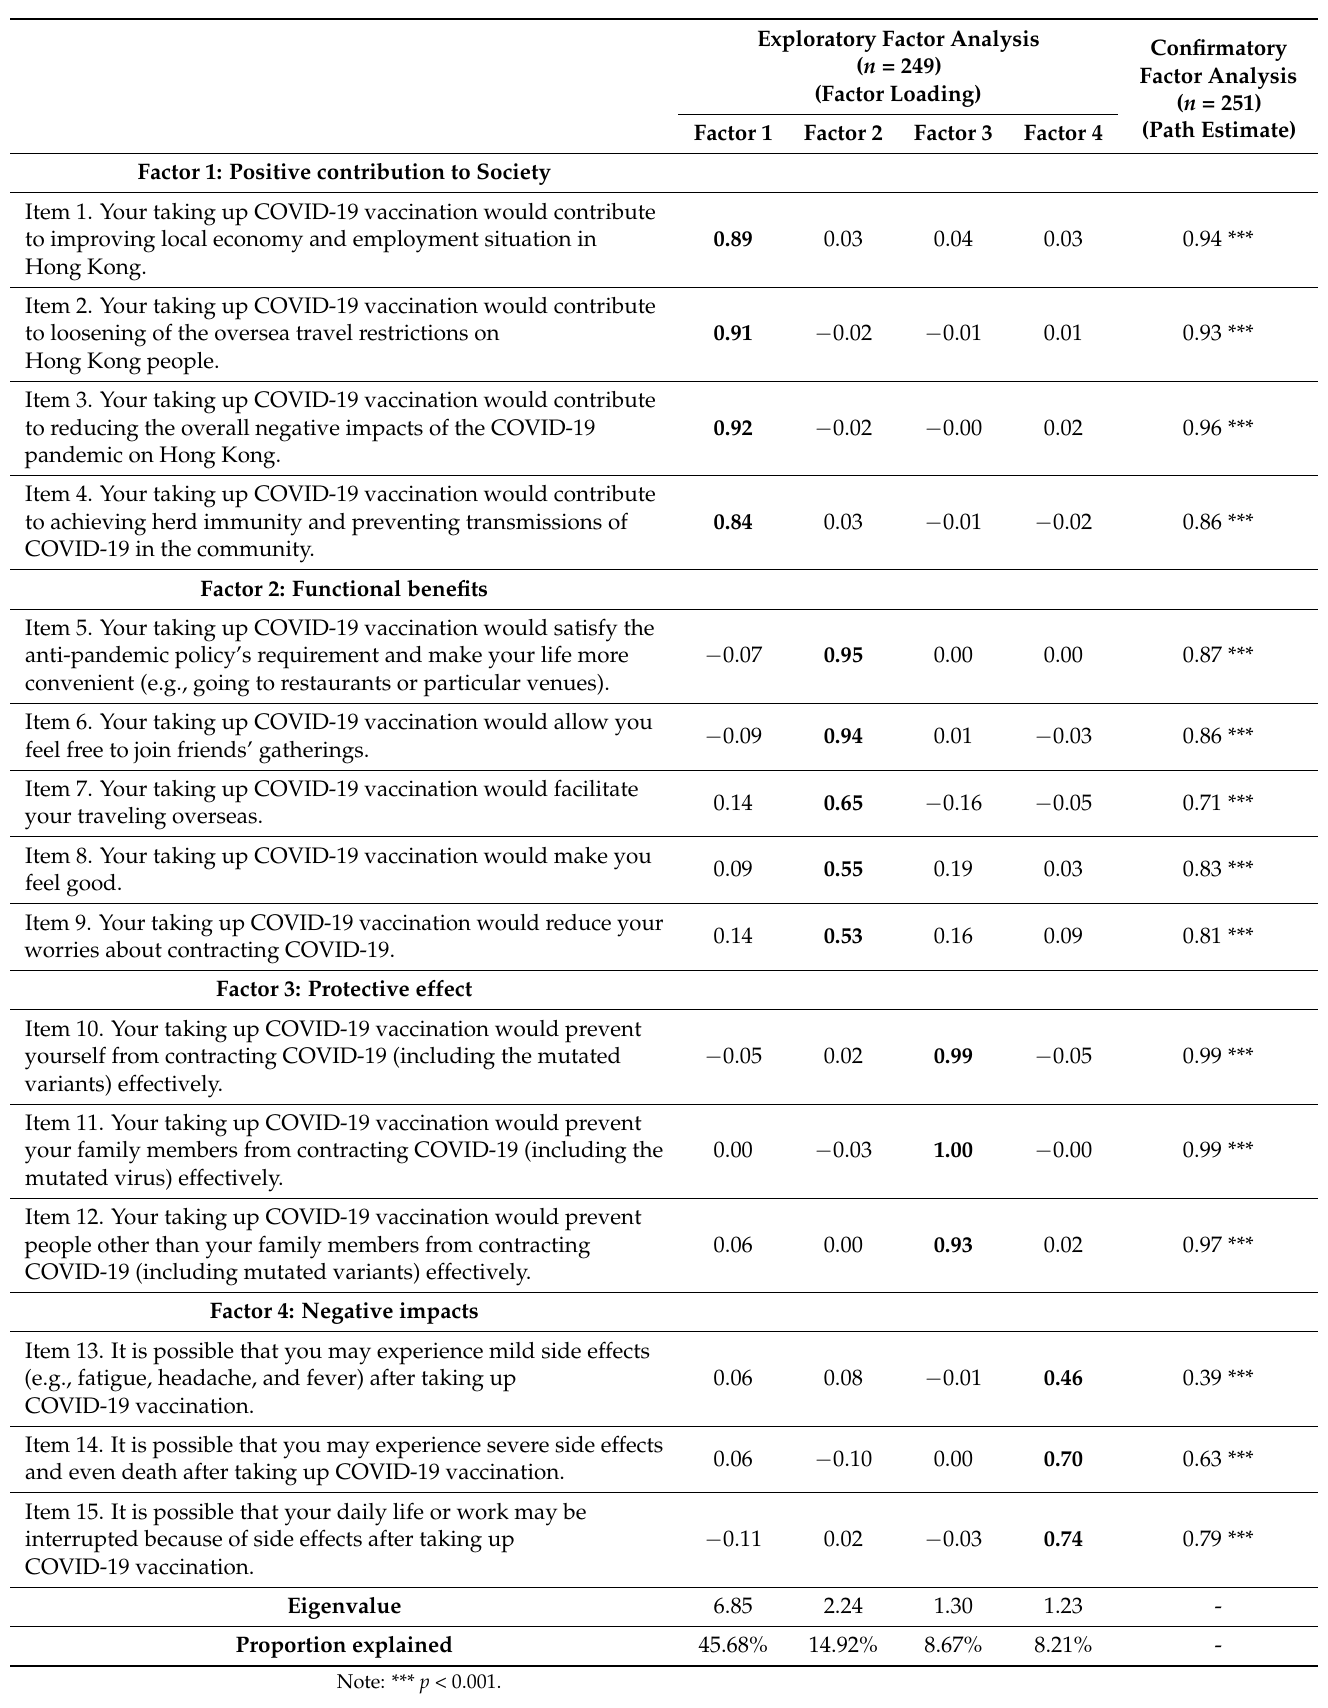
Table 2. Exploratory and confirmatory factor analysis on the OES-COVID-19 using half-split